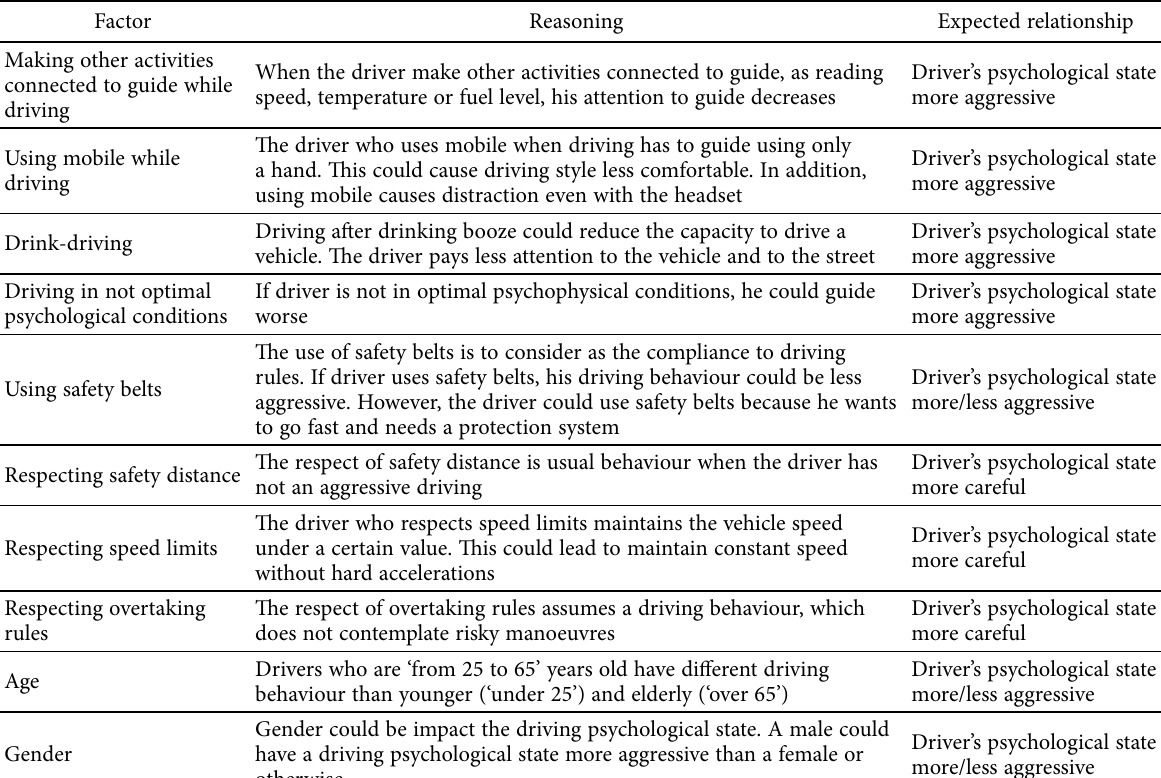
Table 4. A priori hypothesis regarding the psychological state while driving